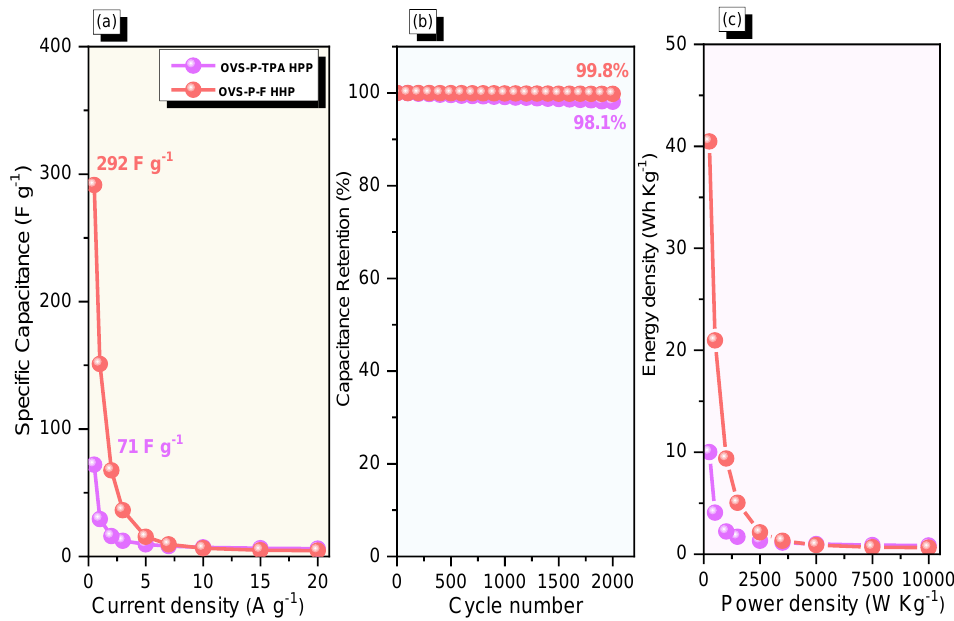
Figure 7. ( a ) Specific capacitance, ( b ) durability, and ( c ) Ragone plots of OVS-P-TPA HPP and OVS- P-F HPP. OVS-P-F